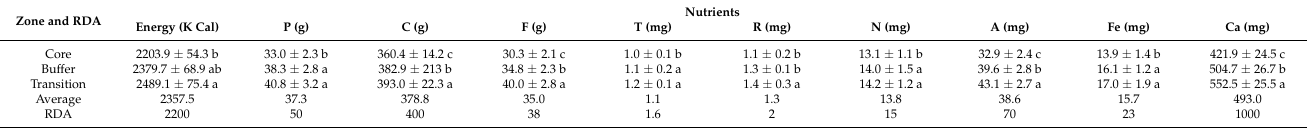
Table 4. Per capita nutrient intake (per day) pattern of Indigenous communities in AABR, Central India. ZoneandRDA Nutrients Energy(KCal)